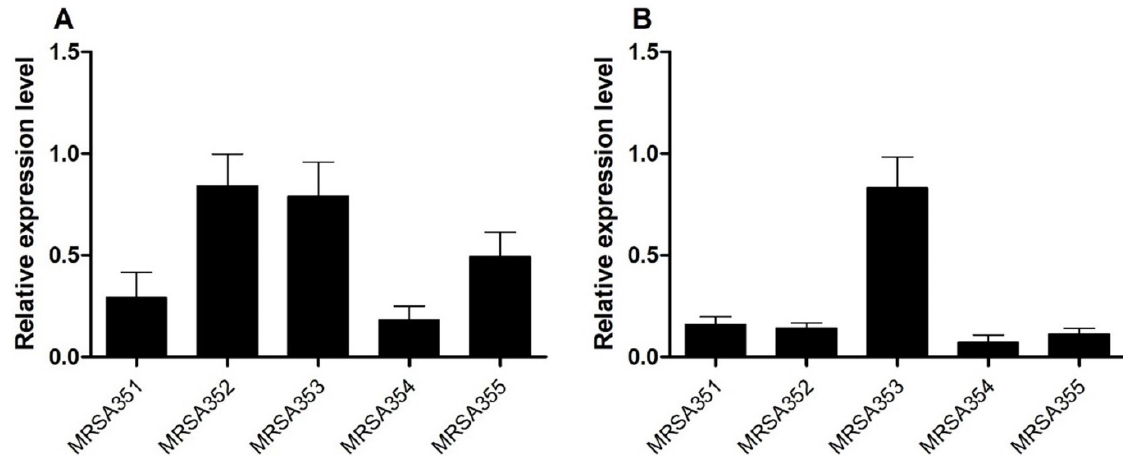
Figure 2. The relative gene expression of the EP genes. The levels of nor A ( A ) and mep A ( B ) in the five MRSA strains were performed by qPCR examining differential modulation of mRNA. Relative expression ratio (fold-change) represents the MRSA associated with EP genes at 24 h, which was calculated using the 2 − ∆∆ CT method. All experiments were performed in triplicate. The data are presented as the mean of expression fold-change normalized against the expression level of S. aureus ATCC 29213 and 16S rRNA.